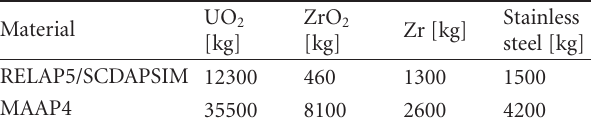
Table 4: Composition of molten material in the reactor vessel lower head, Group 2.